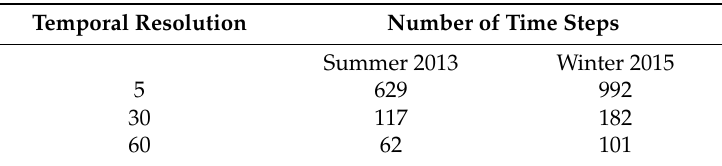
Table 2. The number of time steps considered in the study.